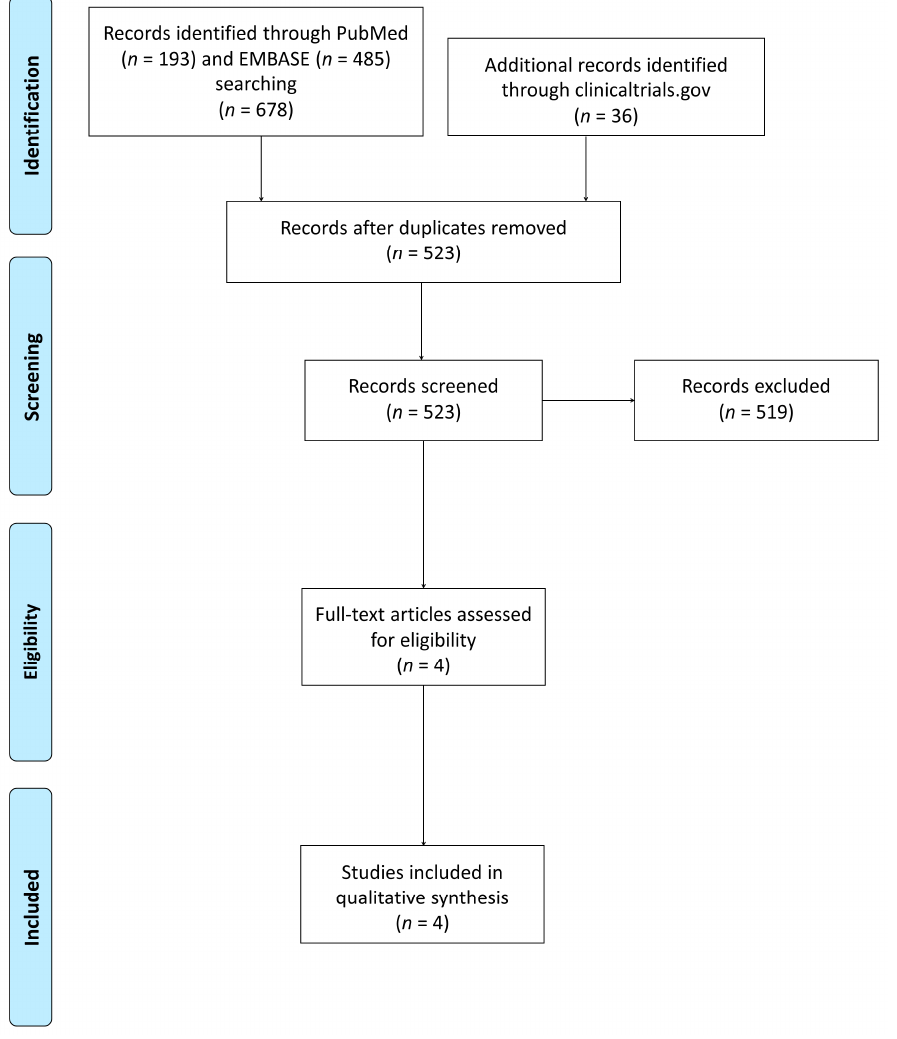
Figure 1. Flowchart of the study.